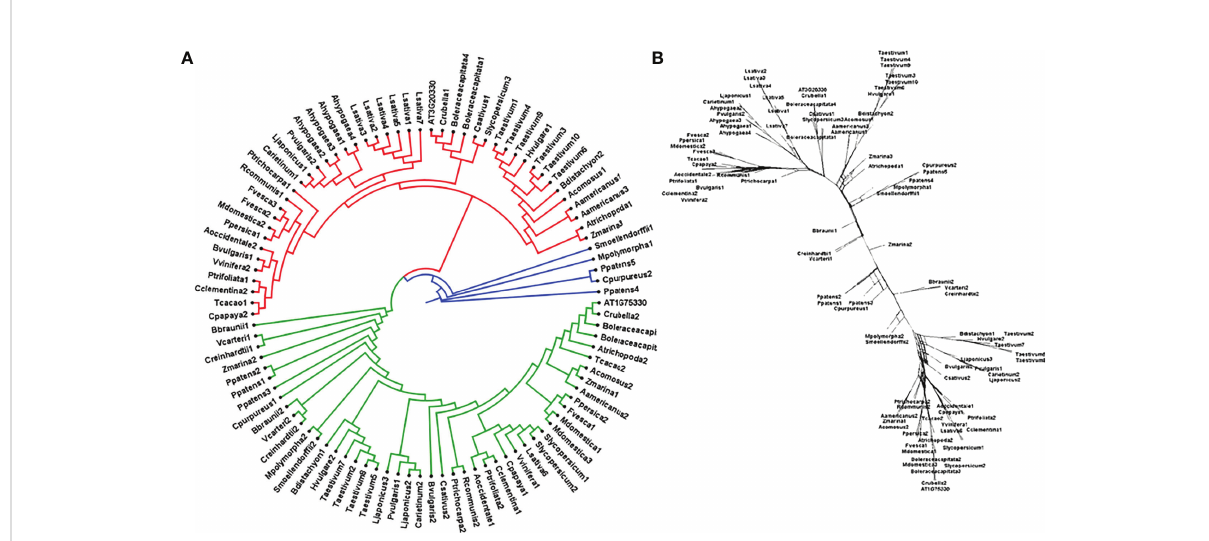
FIGURE 2 Phylogenetic (A) tree of carbamoyltransferase genes in plant groups including fruit representative members, where the red clade is aspartate carbamoyltransferase and the green clade is ornithine carbamoyltransferase. Basal groups are represented by the blue color. (B) The sequence signature splitting is represented by the phylogenetic split network.